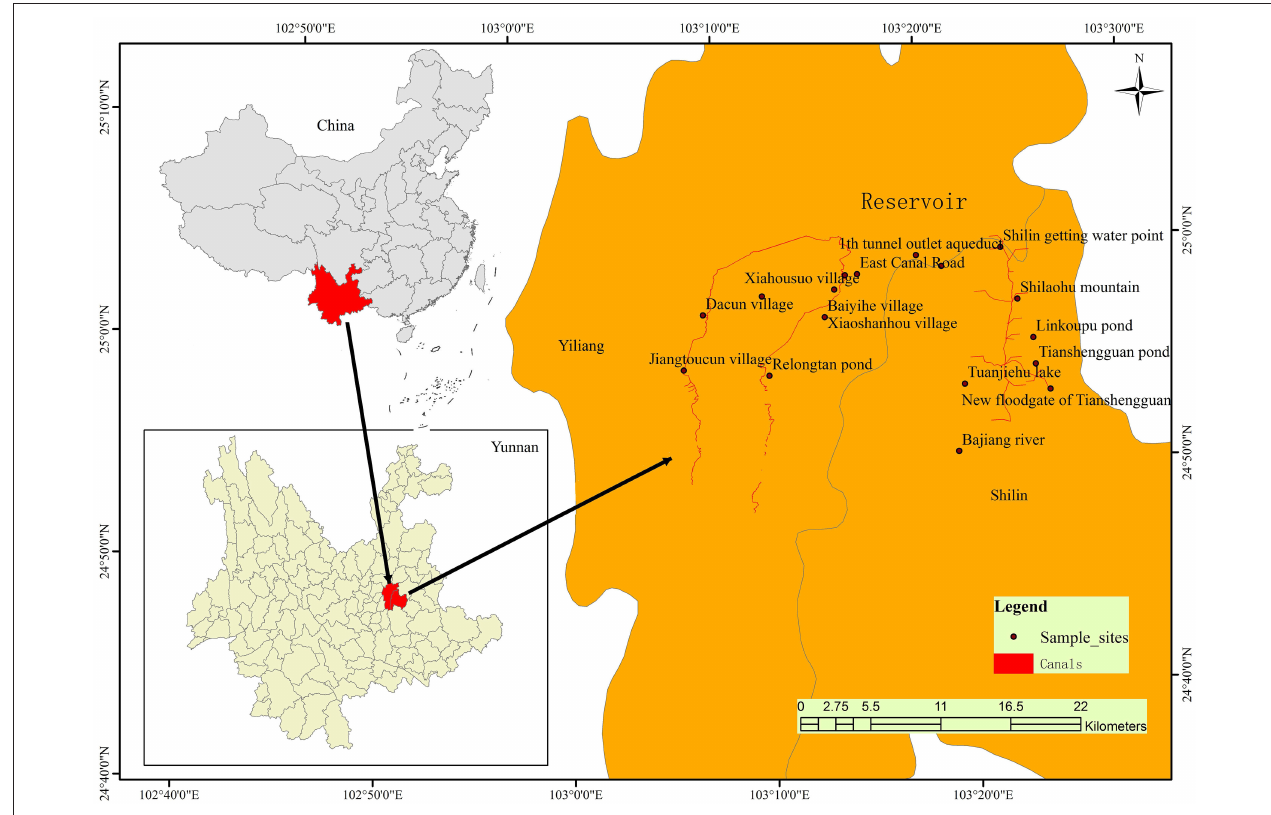
FIGURE 1 | The plant community sampling sites in Chaishitan water conservancy of Yunnan,